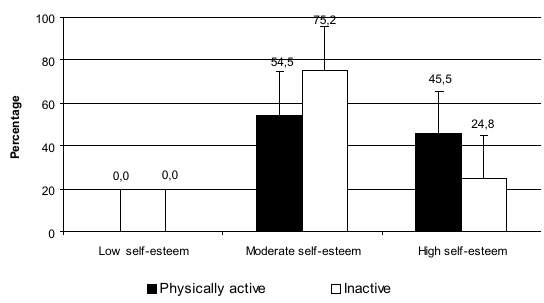
Figure 2. Respondents’ self-esteem χ 2 =35.605, lls=21,